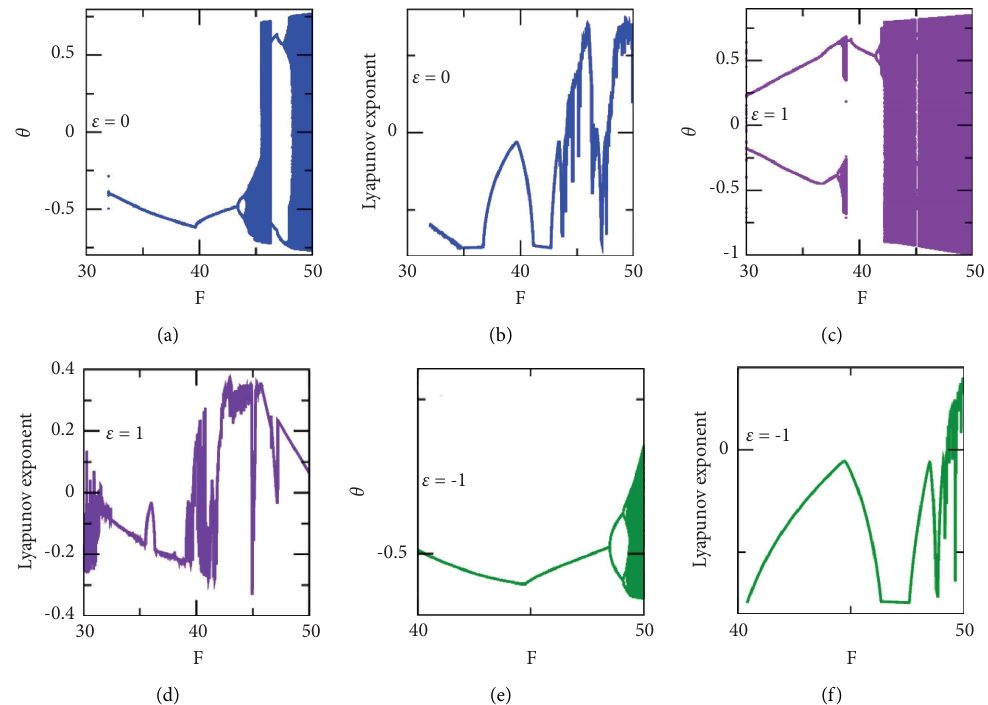
Figure 5: Effect of the passive control force direction on bifurcation diagram and its corresponding Lyapunov exponent for parameter � 0 . 1 ; C � 0 . 05 ; M � 0 . 1 ; K � 0 . 1 ; g � 10 ; U � 2 . 5. values: α � 10 ; β � 1 ; Ω � 2 . ; C 1 2